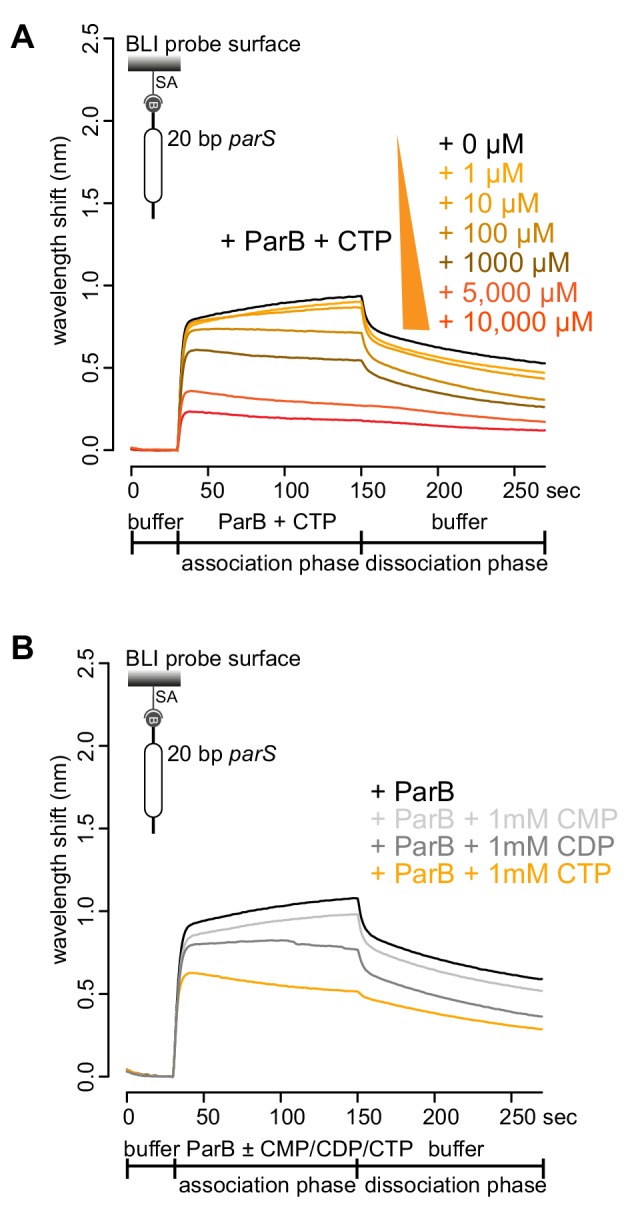
BLI analysis of the interaction between purified Caulobacter ParB and cytidine mono-, di-, or triphosphate.(A) BLI analysis of the interaction between purified Caulobacter ParB and an increasing concentration of CTP-Mg2+. ParB-His6 (1 µM dimer) + 0–10 mM CTP, and a 20 bp DNA duplex containing parS were used for this experiment. (B) BLI analysis of the interaction between a premix of 1 μM Caulobacter ParB-His6 ± 1 mM cytidine mono-, di-, or triphosphate, and a 20 bp parS DNA. A schematic of the DNA substrate is shown above the sensorgram. Mg2+ was included in all buffers for experiments in this figure.Figure 1—figure supplement 3—source data 1.Data used to generate Figure 1—figure supplement 3.